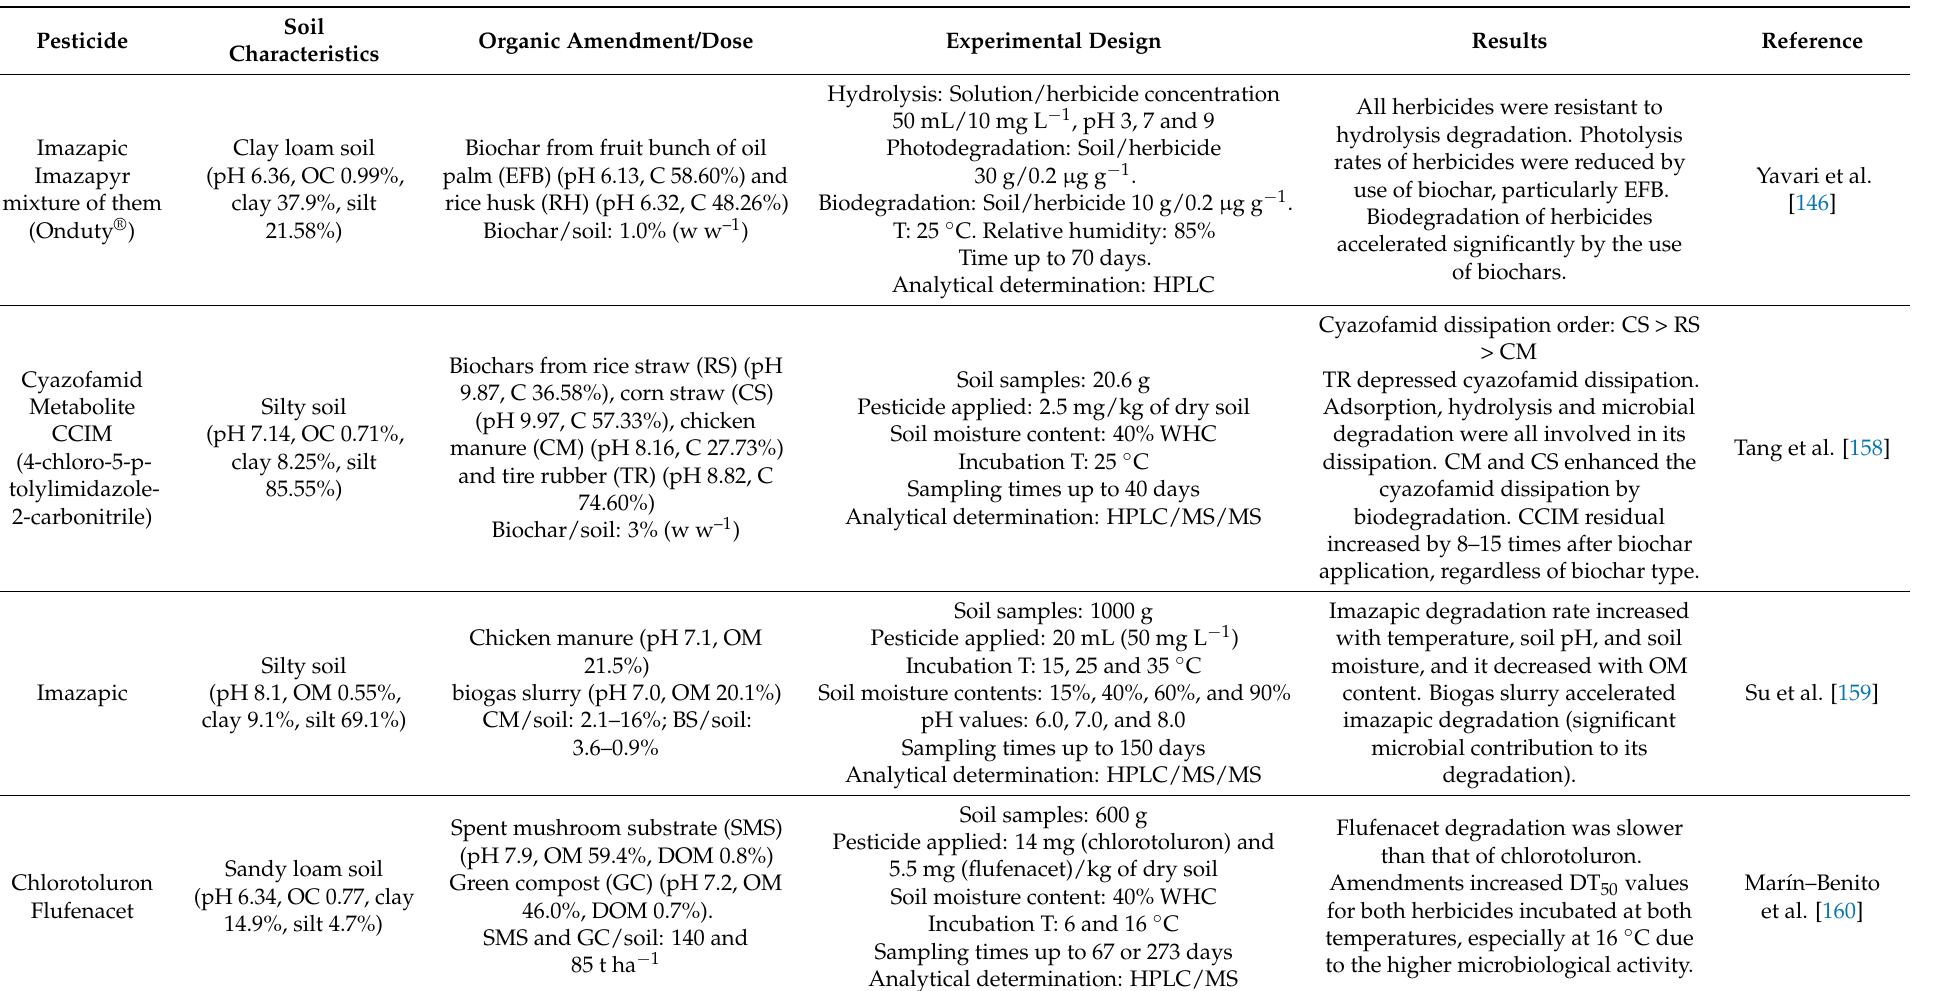
Table 3. Dissipation of pesticides in amended